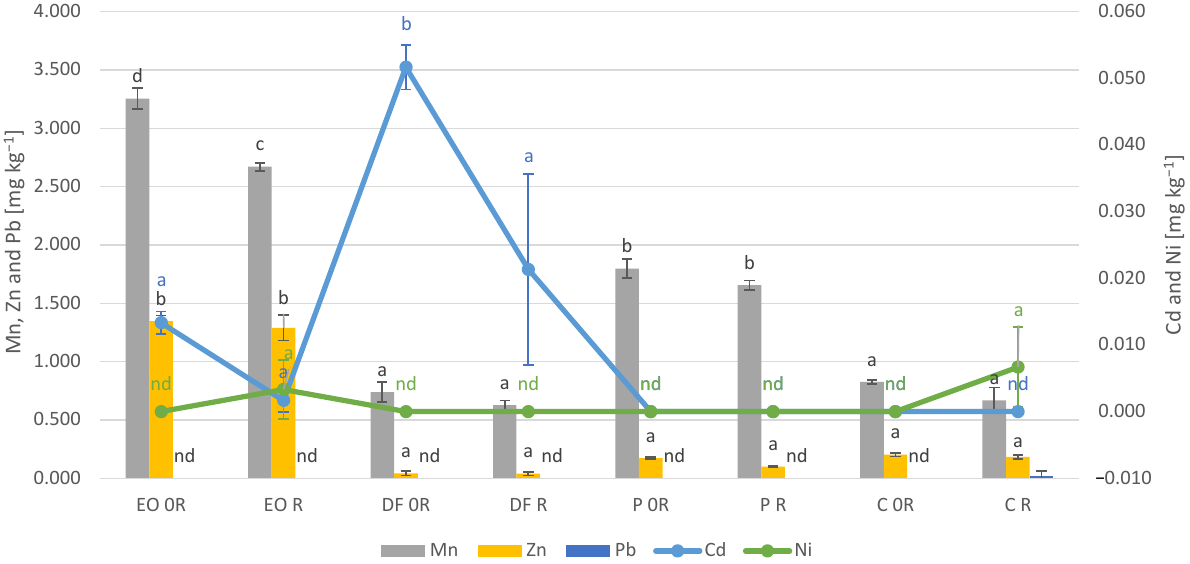
Figure 4. The effect of PDSs and bioremediation on the content of heavy metals in the experimental soils (potentially